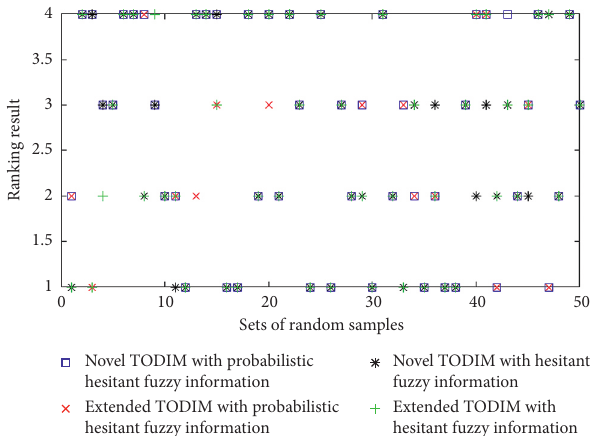
Figure 13: Ranking results of the alternative A